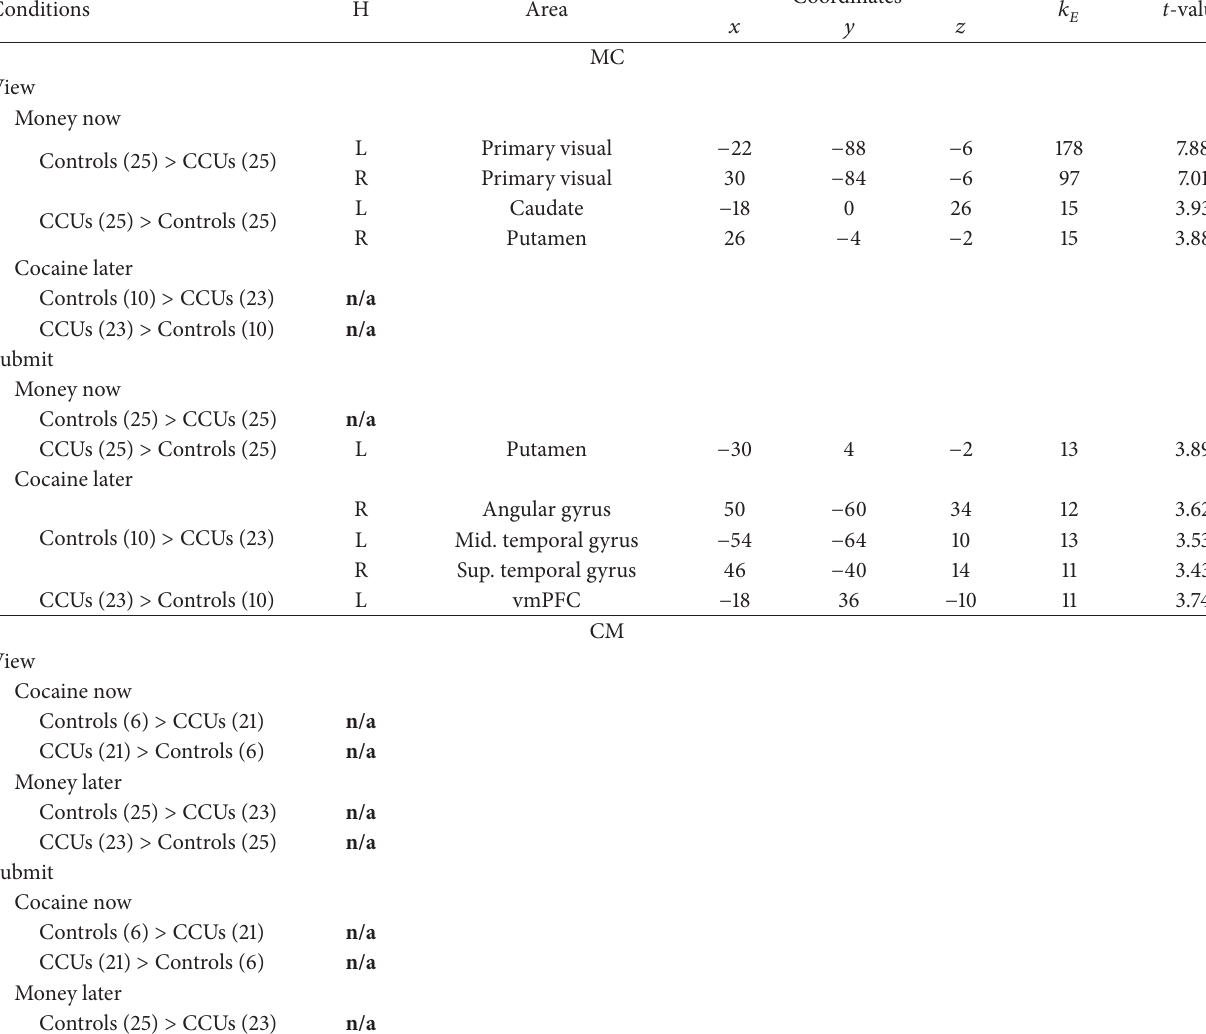
Table 2: Areas of significant BOLD signal differences between controls (Controls) and chronic cocaine users (CCUs) while viewing and submitting choices during cross-commodity blocks of money now versus cocaine later (MC) and cocaine now versus money later